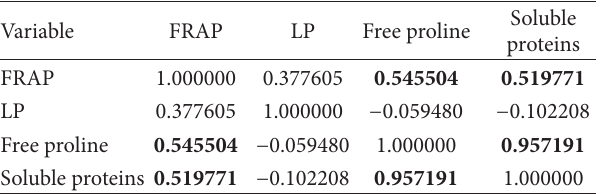
T 3: Correlations between total antioxidant capacity